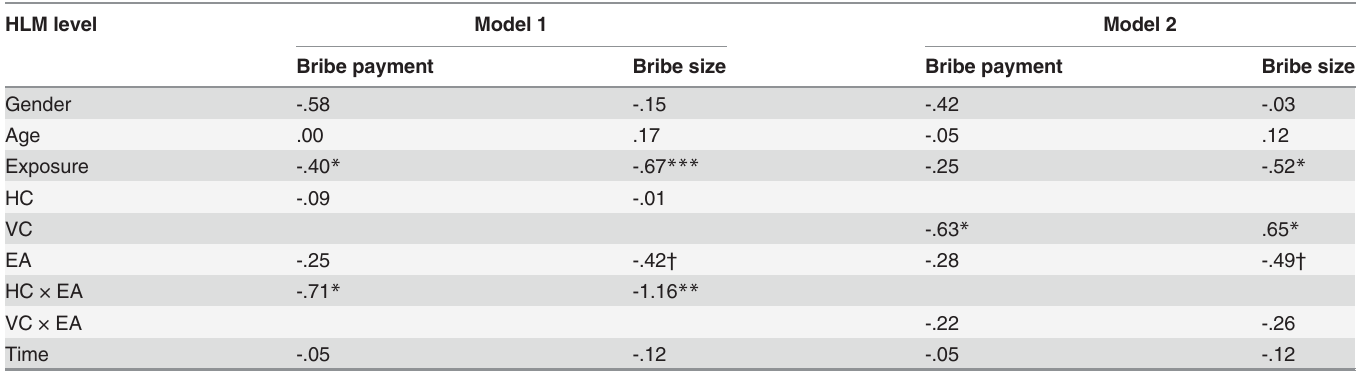
Table 1. Predicting Corruption with Horizontal Collectivism, Vertical Collectivism, and Evaluation Apprehension. HLM